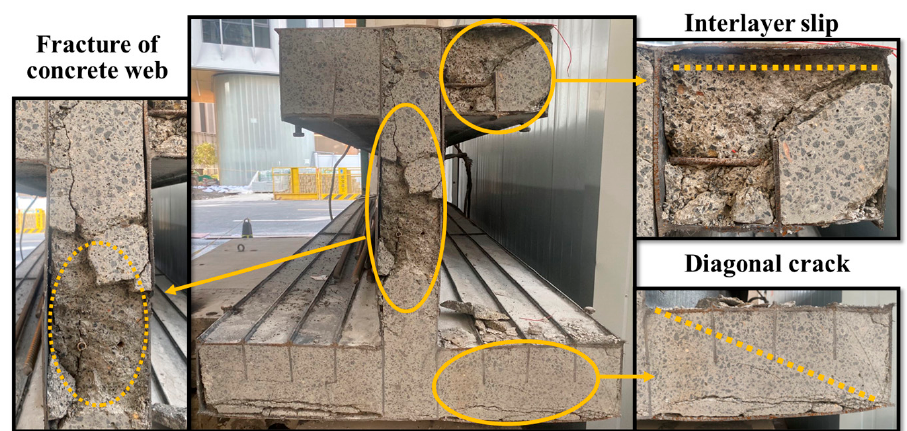
Figure 9. Failure mode of the concrete part of the girder.